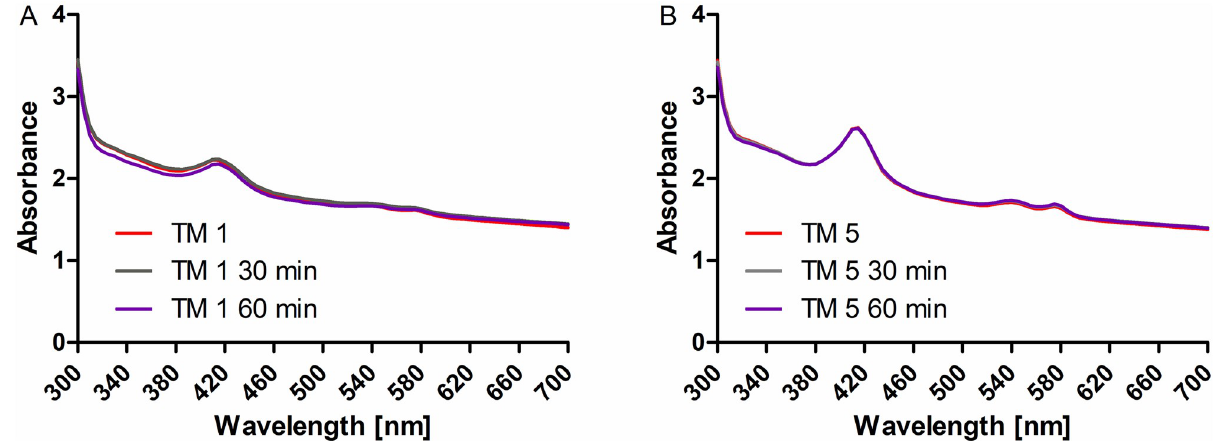
Fig 6. Spectral scan of two TM directly after preparation (red), after 30 min (grey) and after 60 min (purple). No effects of drying were detected without additional wetting for at least 1 hour.